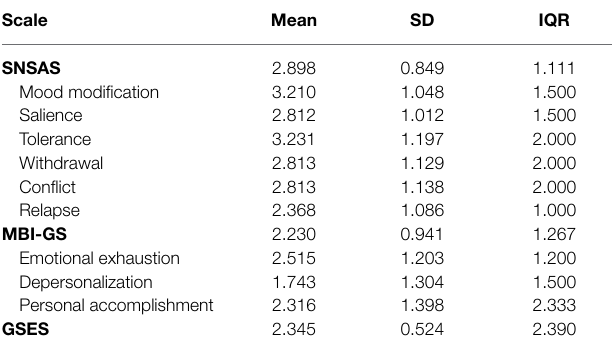
TABLE 2 | Characteristics and SNSAS scores of the respondents. TABLE 3 | Scores on the SNSAS, MBI-GS, and GSES